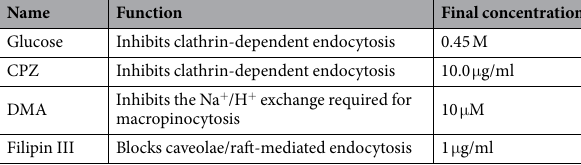
Table 1. Inhibitors and their Function and